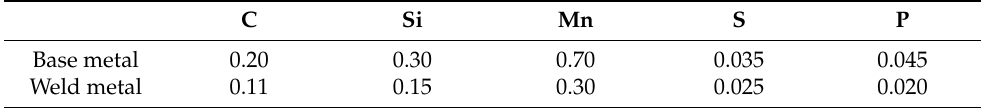
Table 2. Chemical composition of base metal and weld